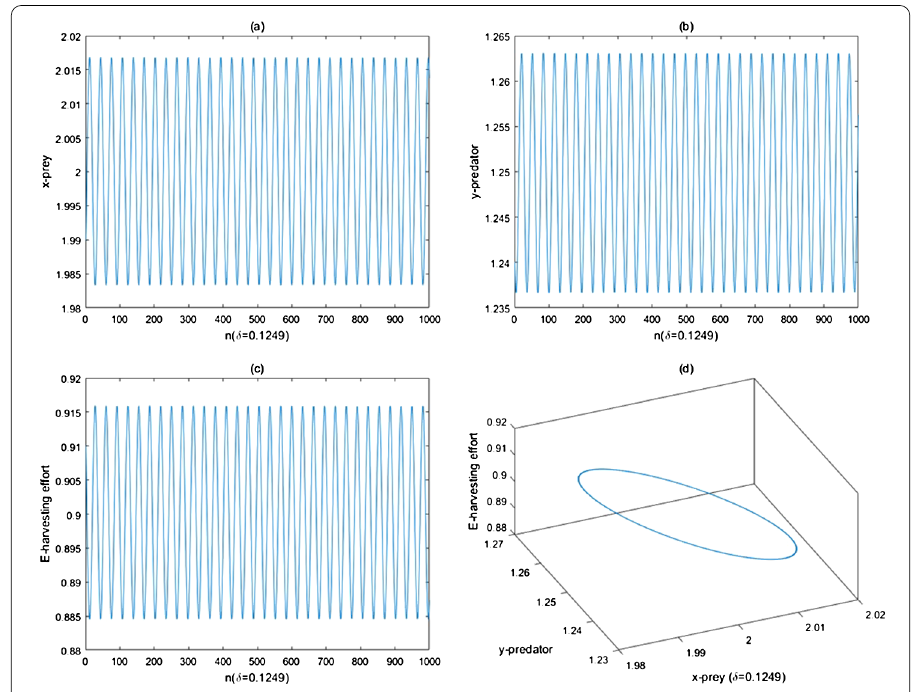
Figure 2 δ = δ 1 – 0.0001. An repelling invariant closed curve bifurcates from the fixed point (2,1.25,0.9)